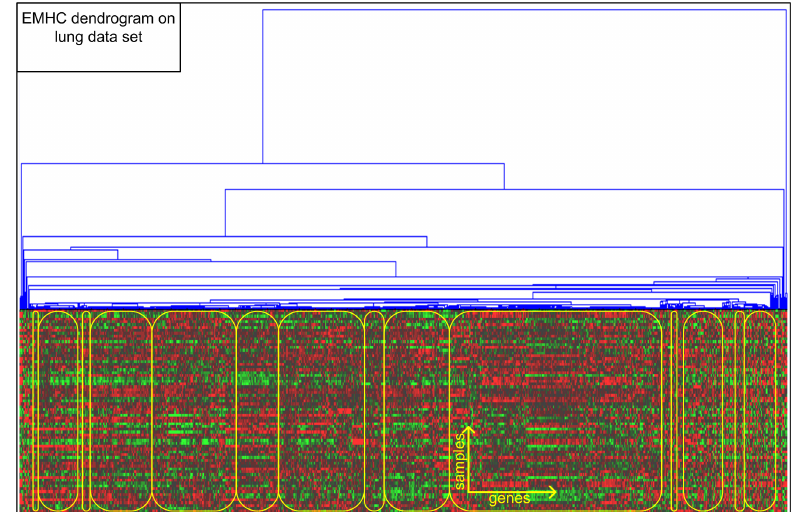
Figure 8: Visualization of dendrogram and microarray for EMHC on lung . Clusters in the level selected of the dendrogram are highlighted.